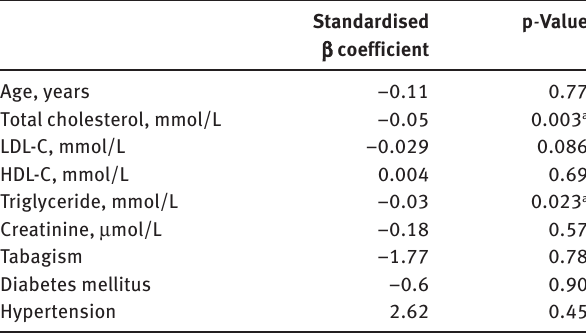
Table 3 Results of the logistic regression analysis using t-Hcy as a dependent variable in deep venous thrombosis